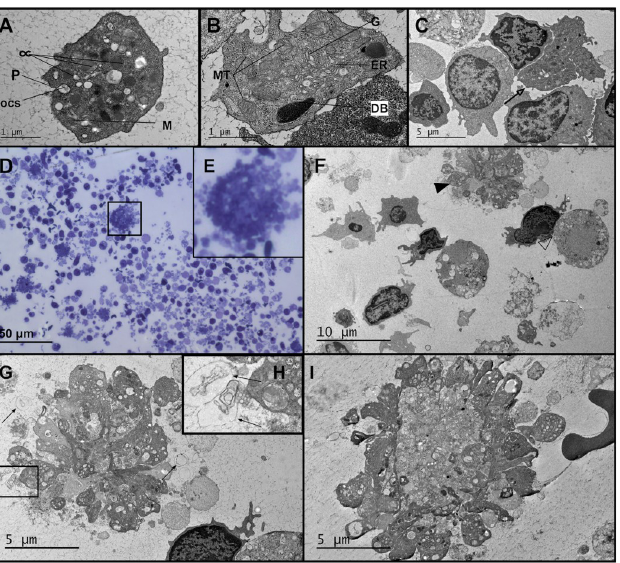
Fig 4. TEM micrographs of platelets, giant platelets and platelet aggregates present in PBMC subpopulation. (A) Equatorial section of a platelet, featuring α -granules ( α ), microfilaments (M), mitochondria (MT) and pores (P) of the open canalicular system (ocs). (B) Equatorial section of a platelet featuring dense bodies (DB), mitochondria (MT), endoplasmic reticulum (ER) and a Golgi body (G). (C) A giant platelet 8 μ m in diameter (open arrow), surrounded by a few PBMCs. (D) A representative TEM image of stimulated T cells (T+Act), and several small and giant platelet aggregates at 200x. The micrograph displays the size of a giant platelet aggregate compared to the rest of PBMCs and platelet clumps. (E) The magnified image of the giant platelet aggregate shown in D. F) TEM image depicting a giant platelet aggregate on the top corner (arrowhead), and an immune synapse between a healthy cell and a necrotic cell (open arrowhead). G) Zoom-in image of F, showing a giant platelet aggregate, possibly formed after being activated by thrombin or other factors, H) Platelet-derived microparticles (PMP) (arrow). PMP like structures can be formed upon platelet activation. I) A giant platelet aggregate that has formed a rosette like structure around a central